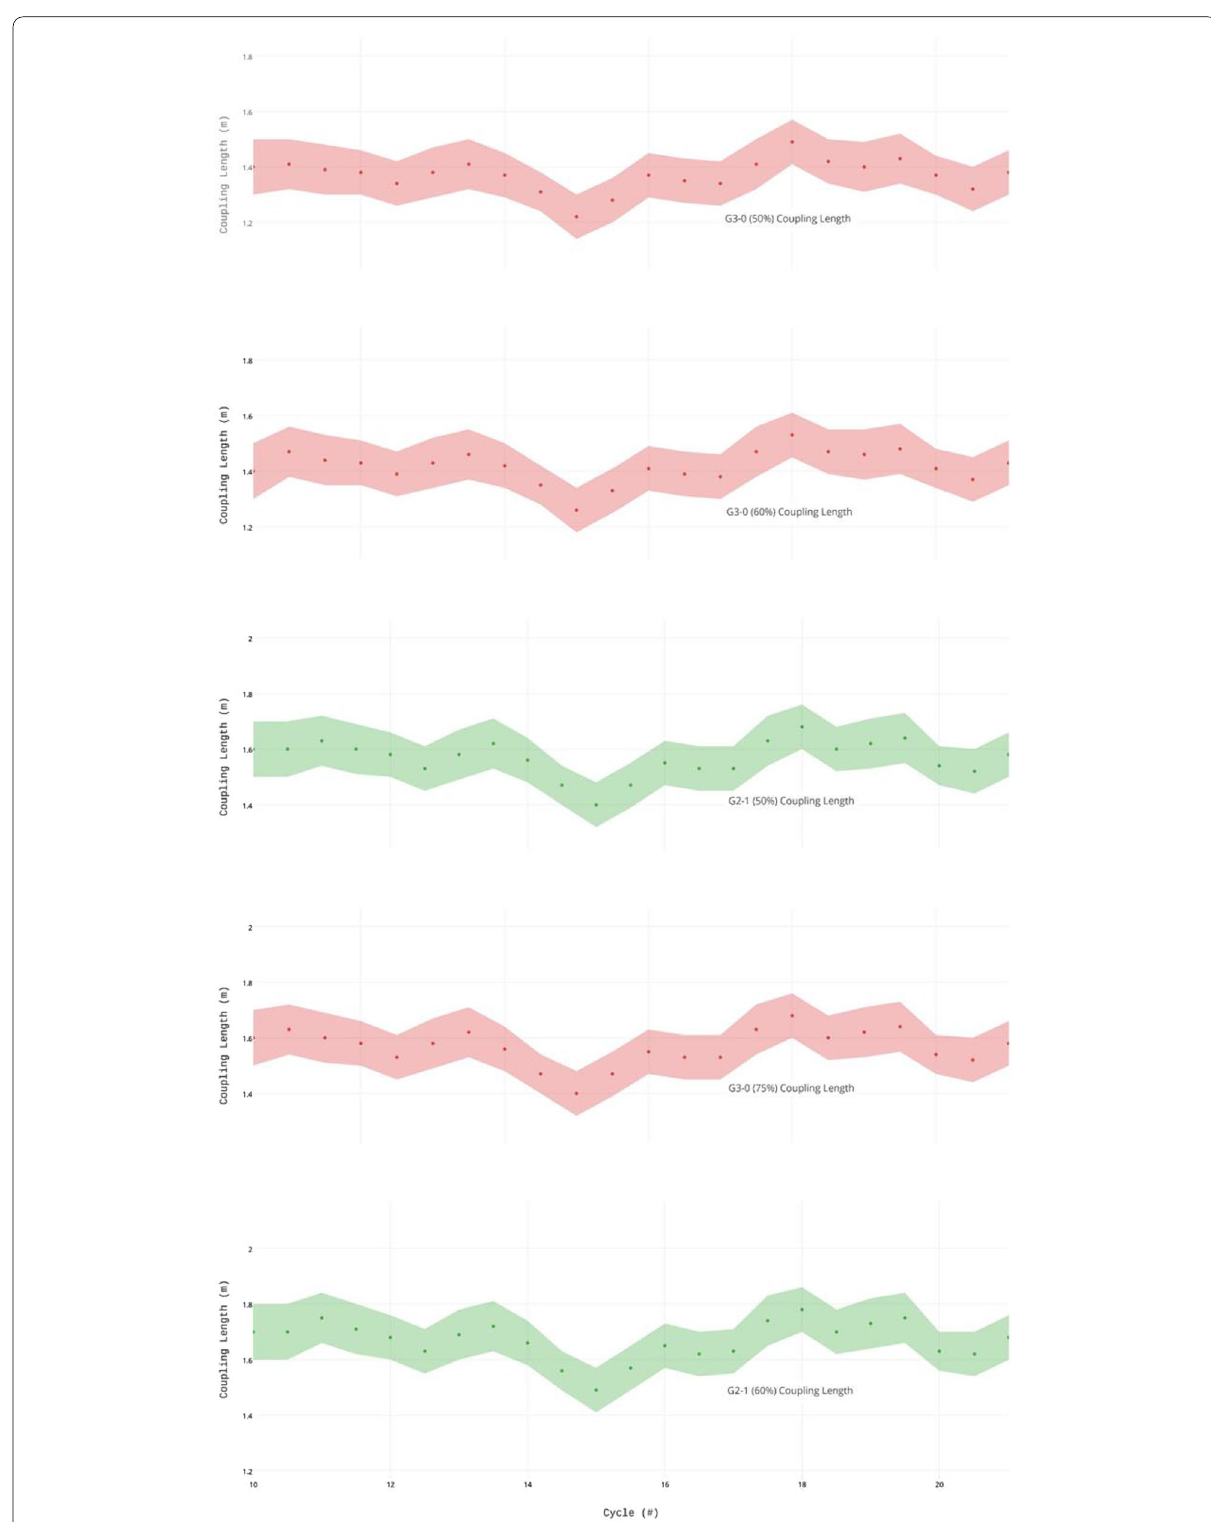
Fig. 10 Coupling length computations for the five trials showing the best solution fitness (Table 2). These correspond to a small range of gaits ( G2 walk and G3 walking trot) and duty